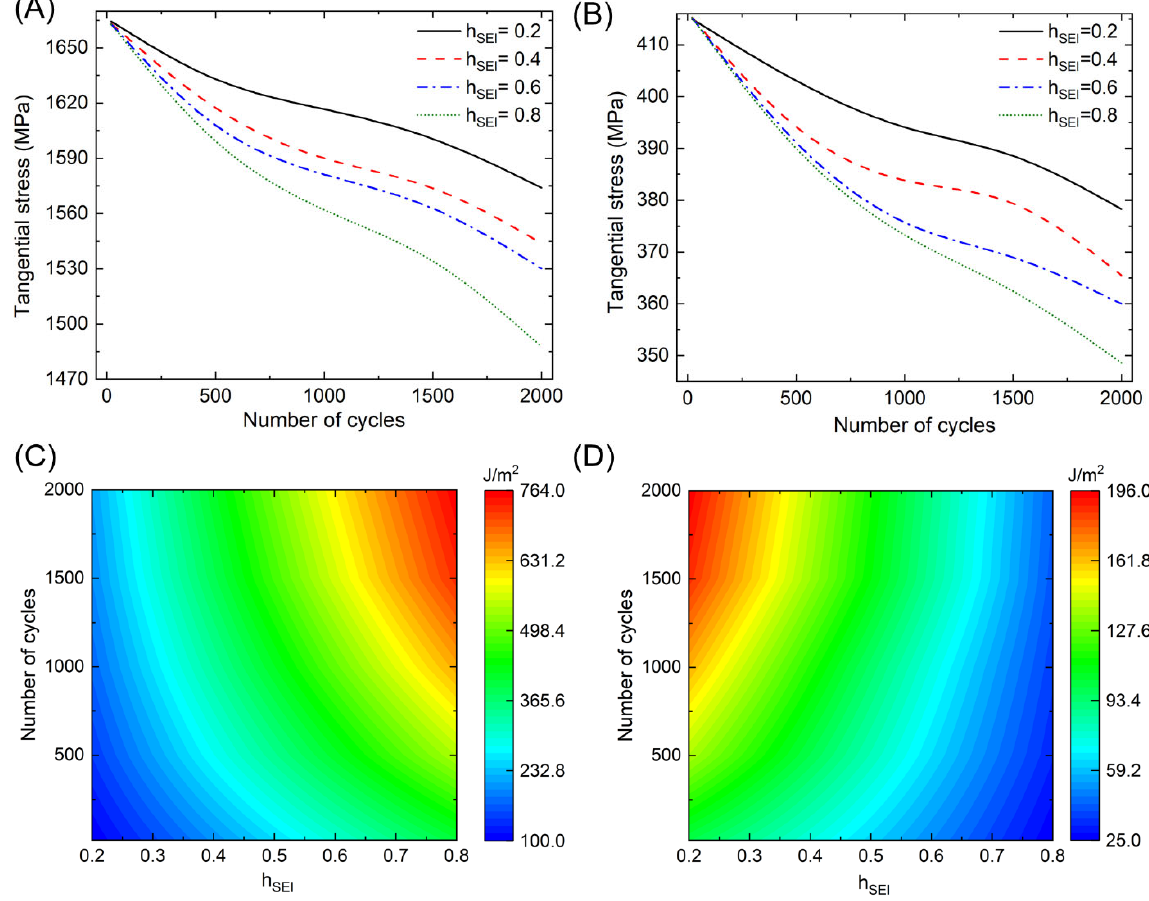
Figure 6. Evolution of tangential stress at the ( A ) P/SEI in interface and ( B ) SEI in /SEI or interface, with different h SEI . Contour plot of fracture energy release rate G f as a function of h SEI and cycle numbers for the ( C ) inorganic and ( D ) organic SEI layer.